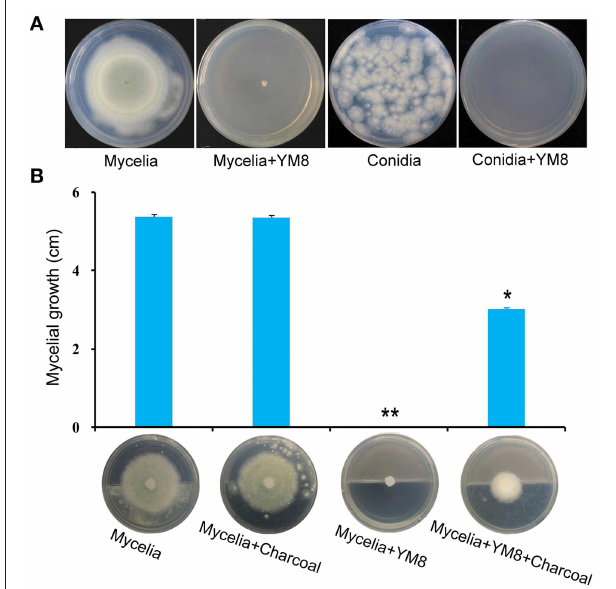
FIGURE 1 | Inhibitory effect of volatiles from bacterial strain YM8 on the mycelial growth and conidial germination of Aspergillus flavus . (A) Mycelia and conidia of A. flavus growing on potato dextrose agar (PDA) in the presence or absence of YM8. (B) Mycelial growth in the presence of YM8 alone or YM8 plus charcoal. Data represent the means ± SE from three measurements. ** P < 0.001 , * P < 0.01